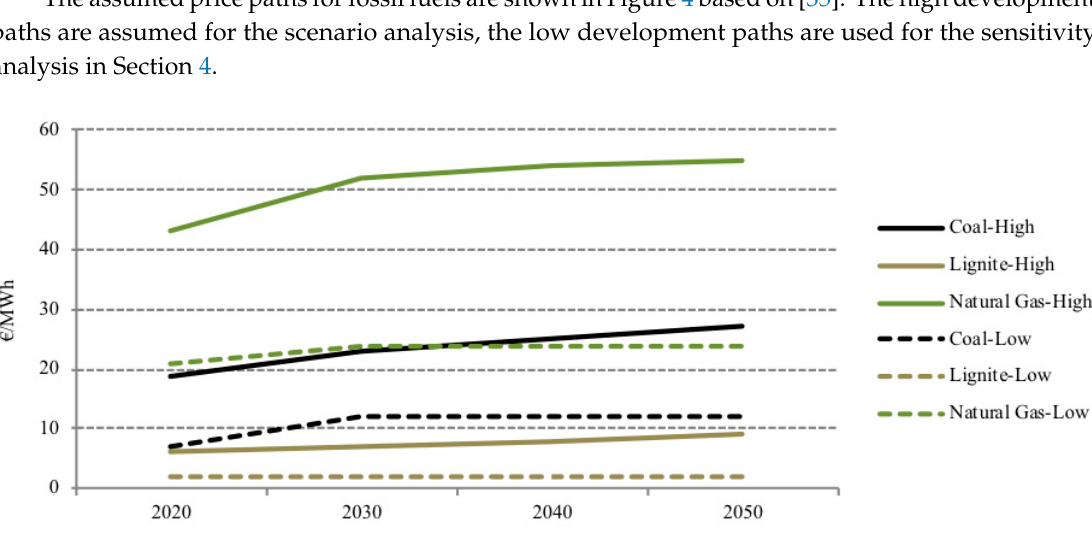
1 Table 4. Assumed economic and technological parameters for local electrolyzers used for hydrogen cars [35]. Yea r